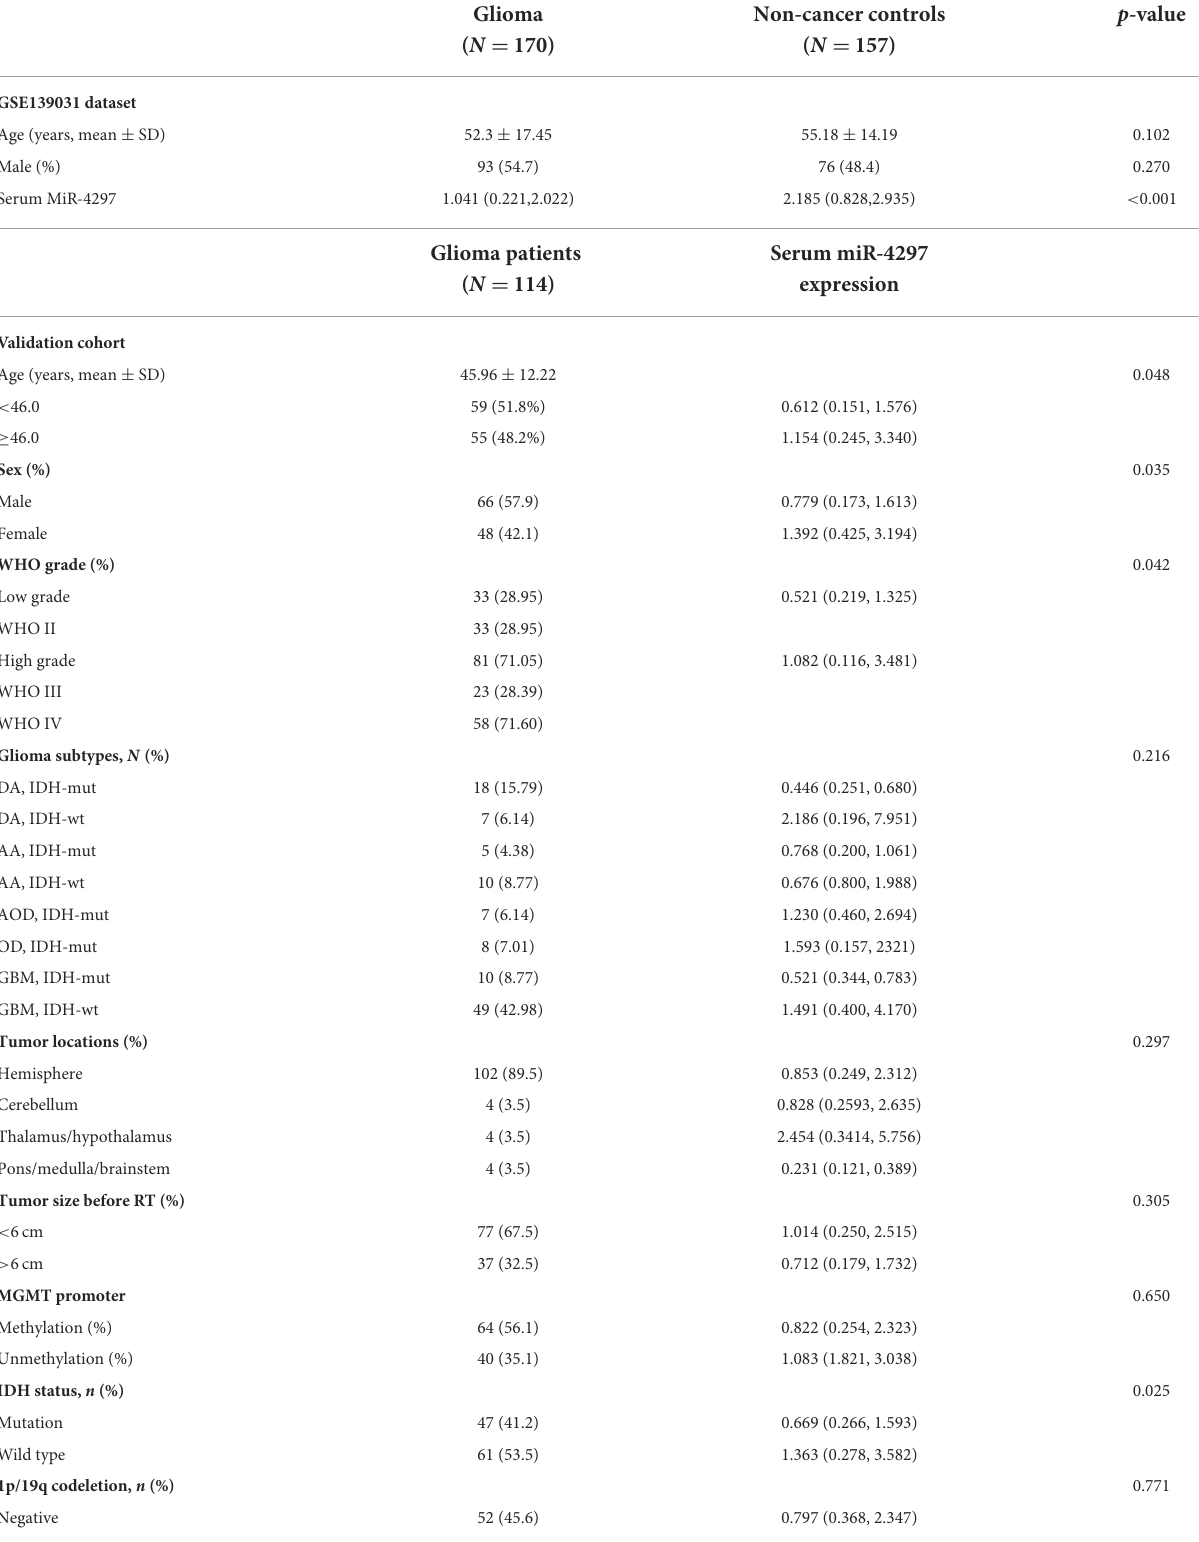
TABLE 1 Demographic data and clinical features of the subjects.